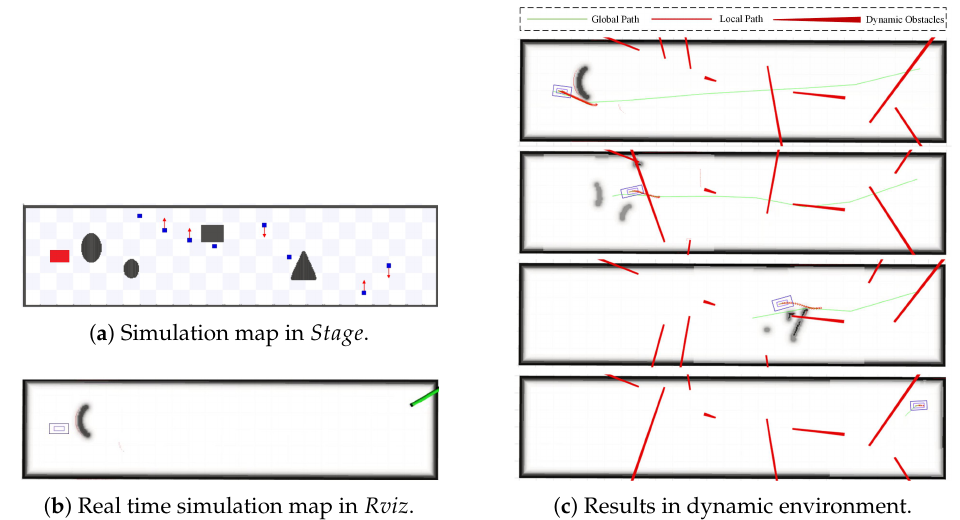
Figure 14. Simulation maps in dynamic environment. In ( c ), global trajectories and real-time local paths are drawn in green and red colors to distinguish. Here we just draw robots driving direction in red instead of robots shape. Blocks in black present obstacles within sensing range.